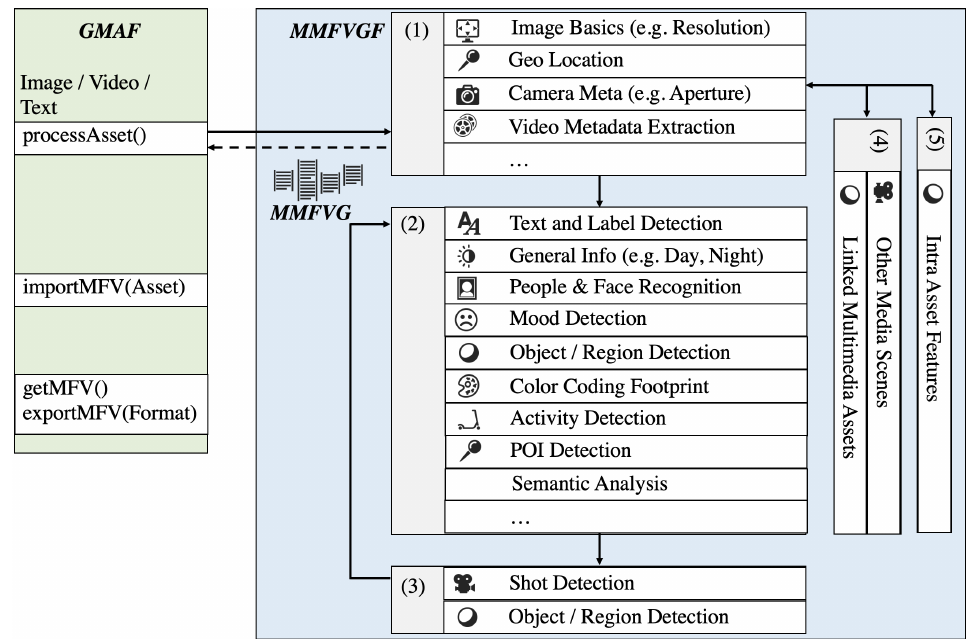
Figure 9. Conceptual processing approach with basic structure of GMAF and MMFVGF.